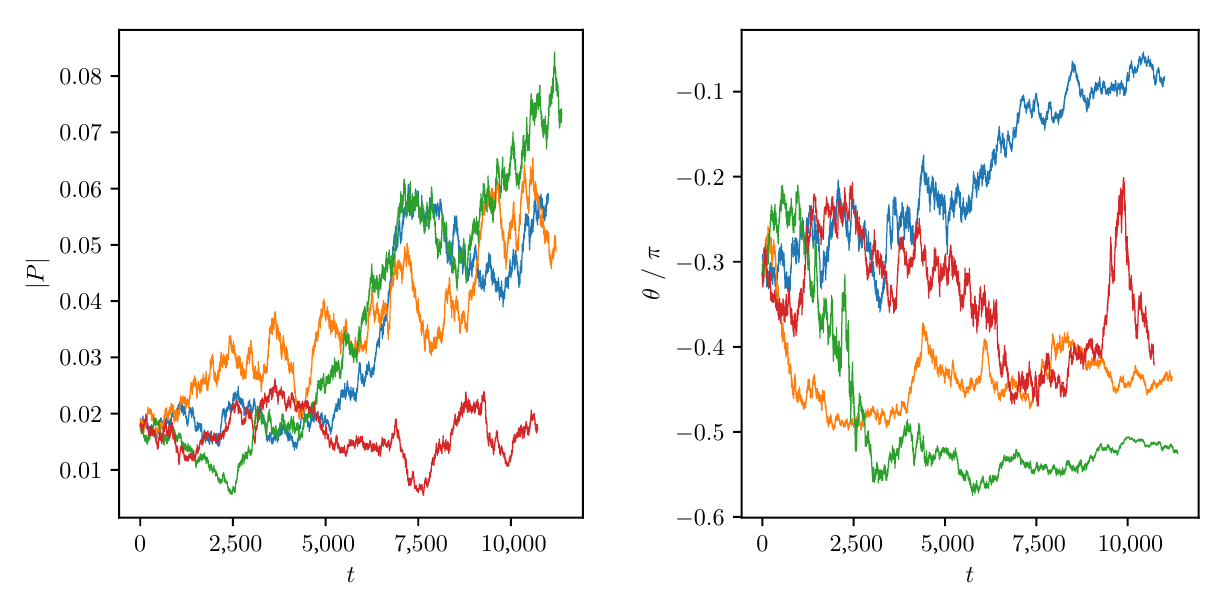
Figure 3. Time dependence of the momentum modulus and angle in four simulations started from the same initial spectrum, 2 , but having different initial phases and different realizations of the random force. f = 0.002. a k | |